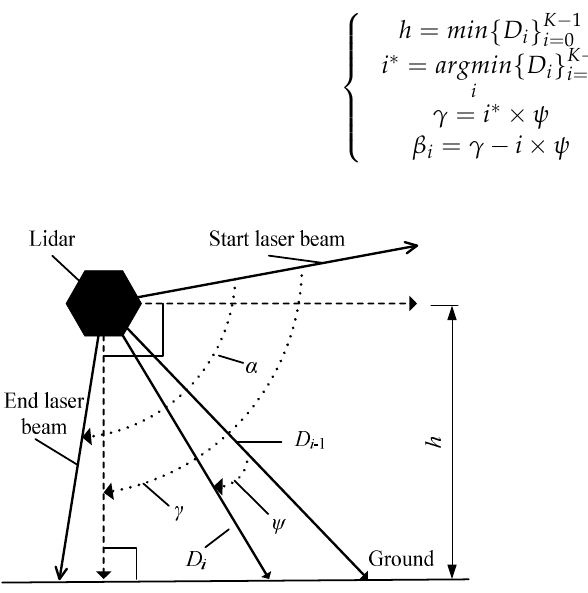
Figure 6. The calibration process.